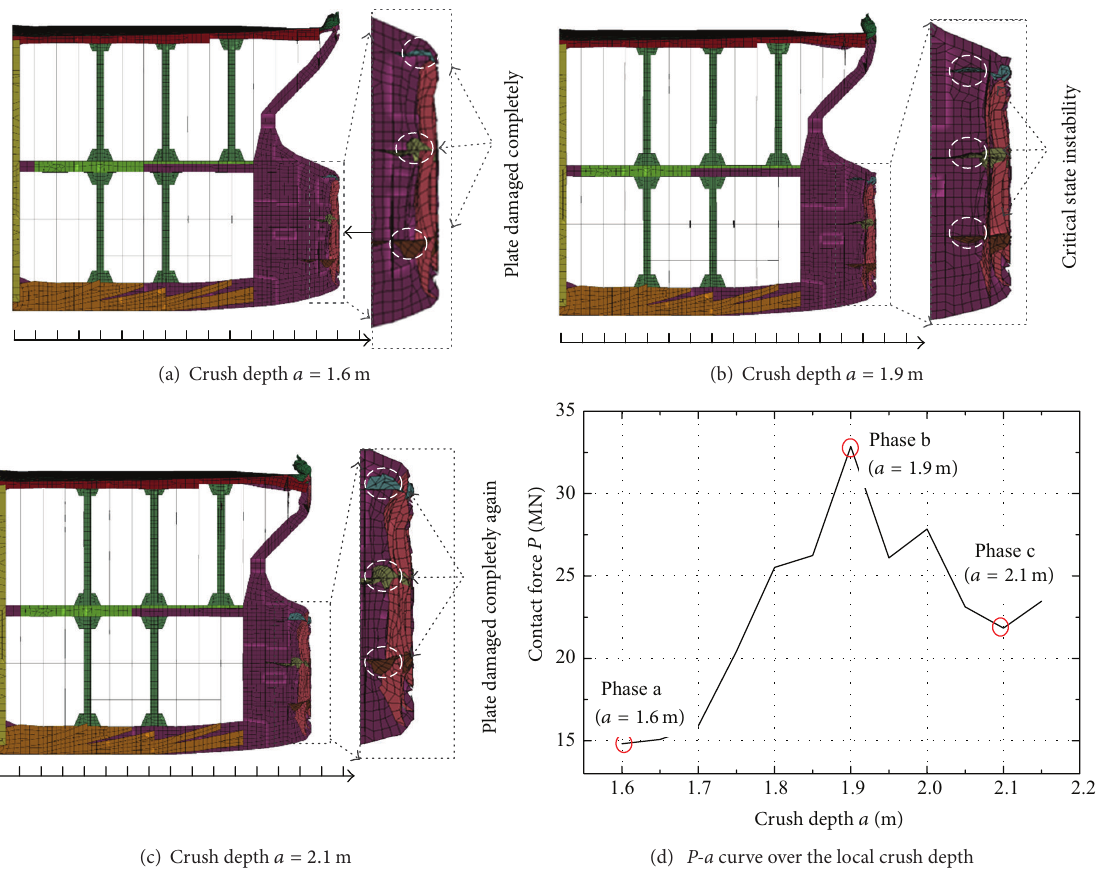
Figure 9: Local characteristics of P-a